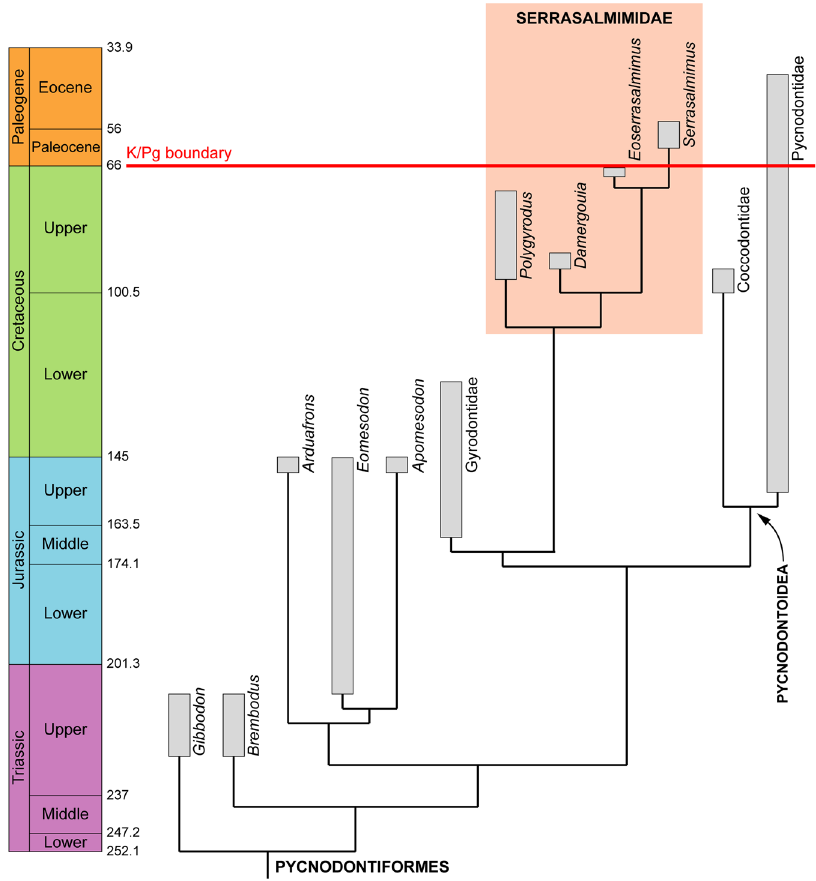
Figure 3. Calibrated phylogenetic hypothesis of pycnodontiform interrelationships. This cladogram (based on a simplified version of the tree shown in Supplementary Fig. S4) shows the disparate origins of Paleogene pycnodont fishes, which are represented by the serrasalmimid Serrasalmimus and by a few members of the